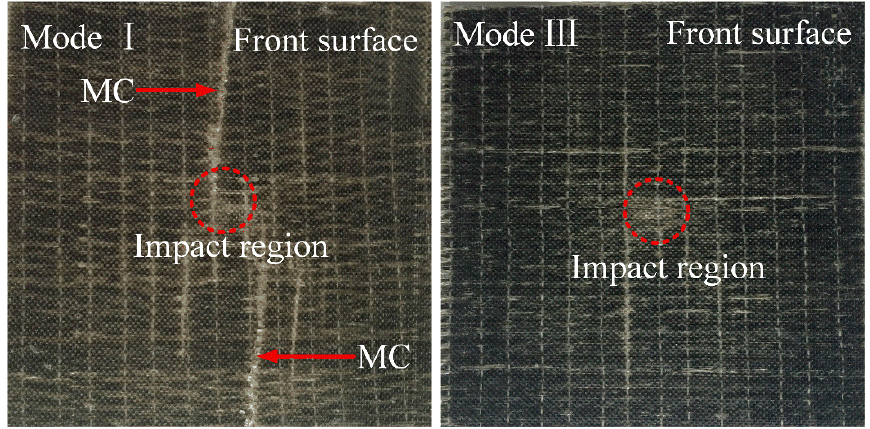
Figure 5. Typical damage morphology of the samples with 30 J impact. Notes: MC indicates the matrix cracking in the figure.